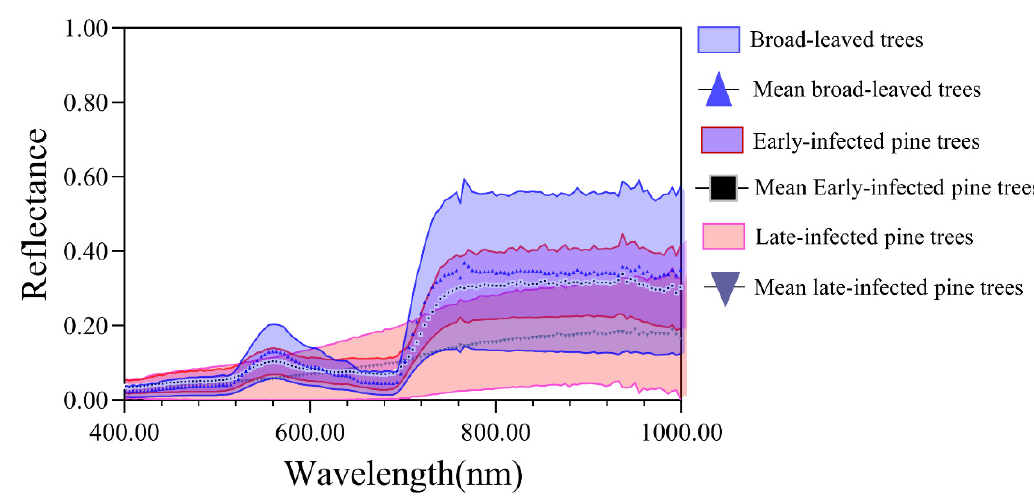
Figure 11. The reflectance curve of broad-leaved trees, early infected pine trees, and late infected pine trees.